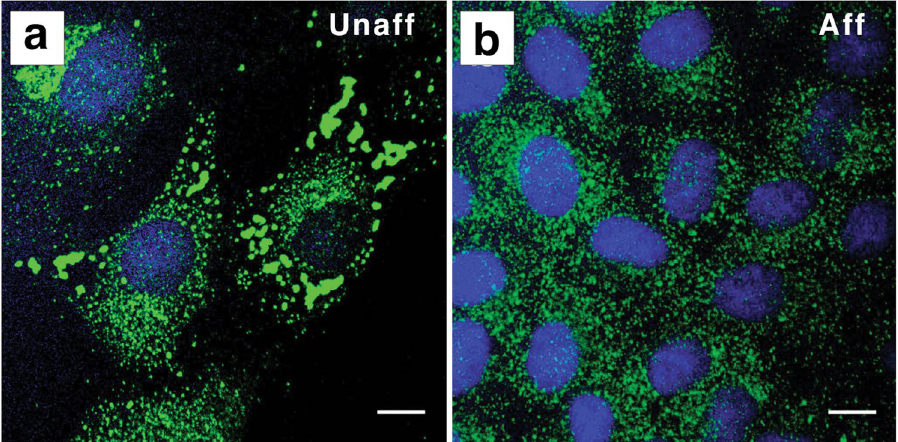
Figure 8. Distribution of 58 K Golgi-associated protein in affected and unaffected renal interstitial fibroblasts. ( a , b ) Immunofluorescence (green) labeling, using anti-Golgi 58 K protein antibody, was carried out in cultured renal interstitial fibroblasts cultured from unaffected ( a ) and affected ( b ) newborn lamb kidneys ( a ). The 58 K protein immunofluorescence was more evenly distributed in small particles in the cytoplasm of the affected renal interstitial fibroblasts, compared to the distribution in large and small particles of unaffected renal interstitial fibroblasts. Cell nuclei were stained with DAPI (blue). Scale bars = 10 μ